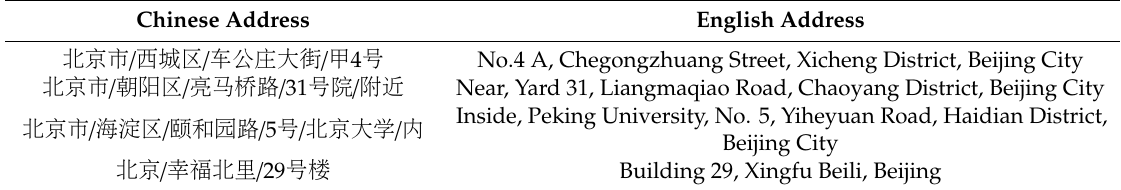
Table 4. Examples of manual segmentation of POI address